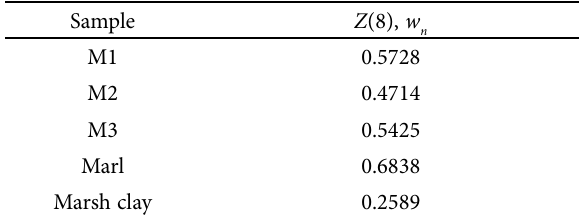
Table 12. Disintegration number Z (8), w